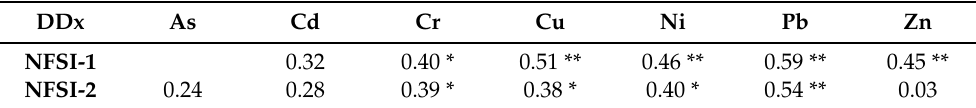
Figure 5. Percentage cumulative frequency distribution of the DDx concentrations (DDT and metabolites) of the nationwide NFSI sample in humus layer and 0–5 cm depth; plots of the NFSI in Brandenburg are indicated by green circles. Table 8. Correlation coefficients between DDx concentrations (sum of DDT and its metabolites) and the As, Cd, Cr, Cu, Ni, Pb and Zn concentrations in the humus layer of the Brandenburg NFSI locations differentiated for data of NFSI-1 (n = 36) and NFSI-2 (n = 50); significance: * p < 0.05, ** p < 0.01.